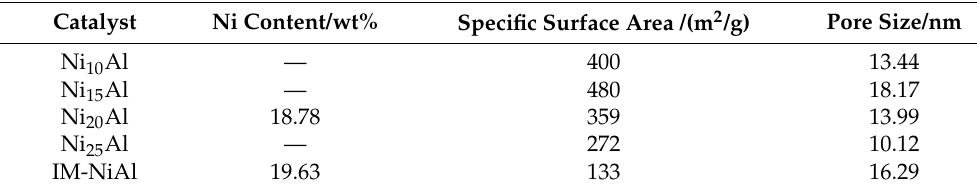
Figure 1. ( a ) N 2 adsorption and desorption isotherms and ( b ) pore size distribution curves of catalyst samples. Table 1. Physicochemical properties of Ni x Al and IM-NiAl catalysts.